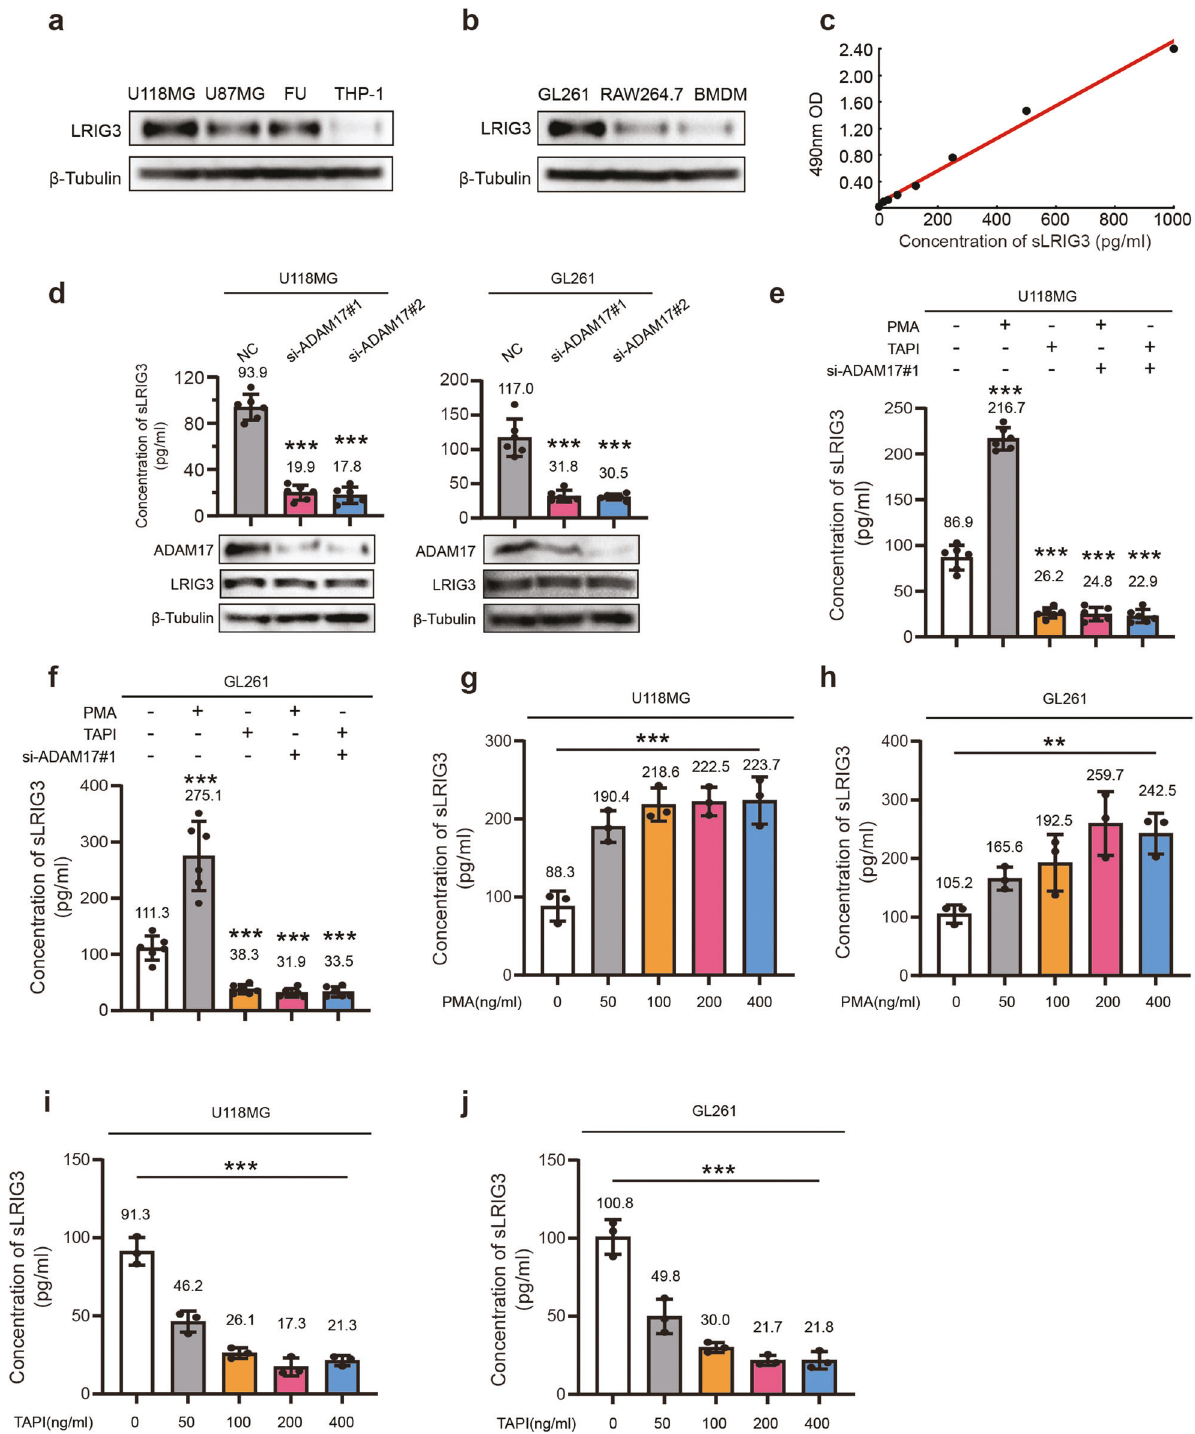
Fig. 2 ADAM17 promotes the secretion of soluble LRIG3 by glioma cells. a Immunoblots for LRIG3 in the cell lysates of huamn glioma cell lines (U118MG, U87MG, FU) and macrophage-like cell line (THP-1). b Immunoblots for LRIG3 in the cell lysates of mouse glioma cell line (GL261) and macrophage-like cell line (RAW264.7 and BMDM). c ELISA standard curve showing the correlation relationship of LRIG3 concentrations and the log of the optical density 490. d ELISA and immunoblots for the expression of soluble LRIG3 protein of supernatant medium (up panel), ADAM17, and LRIG3 in the cell lysates (down panel) in negative control and si-ADAM17 U118MG and GL261 cells. n = 6 biological replicates for ELISA assay. One-way ANOVA with bonferroni correction. e , f ELISA for the expression of soluble LRIG3 protein of supernatant medium in U118MG ( e ) and GL261 ( f ) cells with stimulation of ADAM17 agonist PMA, ADAM17 inhibitor TAPI and ADAM17 siRNAs. n = 6 biological replicates. One-way ANOVA with bonferroni correction. g , h ELISA for the expression of soluble LRIG3 protein of supernatant medium in U118MG ( g ) and GL261 ( h ) cells in the absence or presence of increasing doses of ADAM17 agonist PMA. n = 3 biological replicates. One-way ANOVA. i , j ELISA for the expression of soluble LRIG3 protein of supernatant medium in U118MG ( i ) and GL261 ( j ) cells in the absence or presence of increasing doses of ADAM17 inhibitor TAPI. n = 3 biological replicates. One-way ANOVA. Cell Death and Disease (2023)